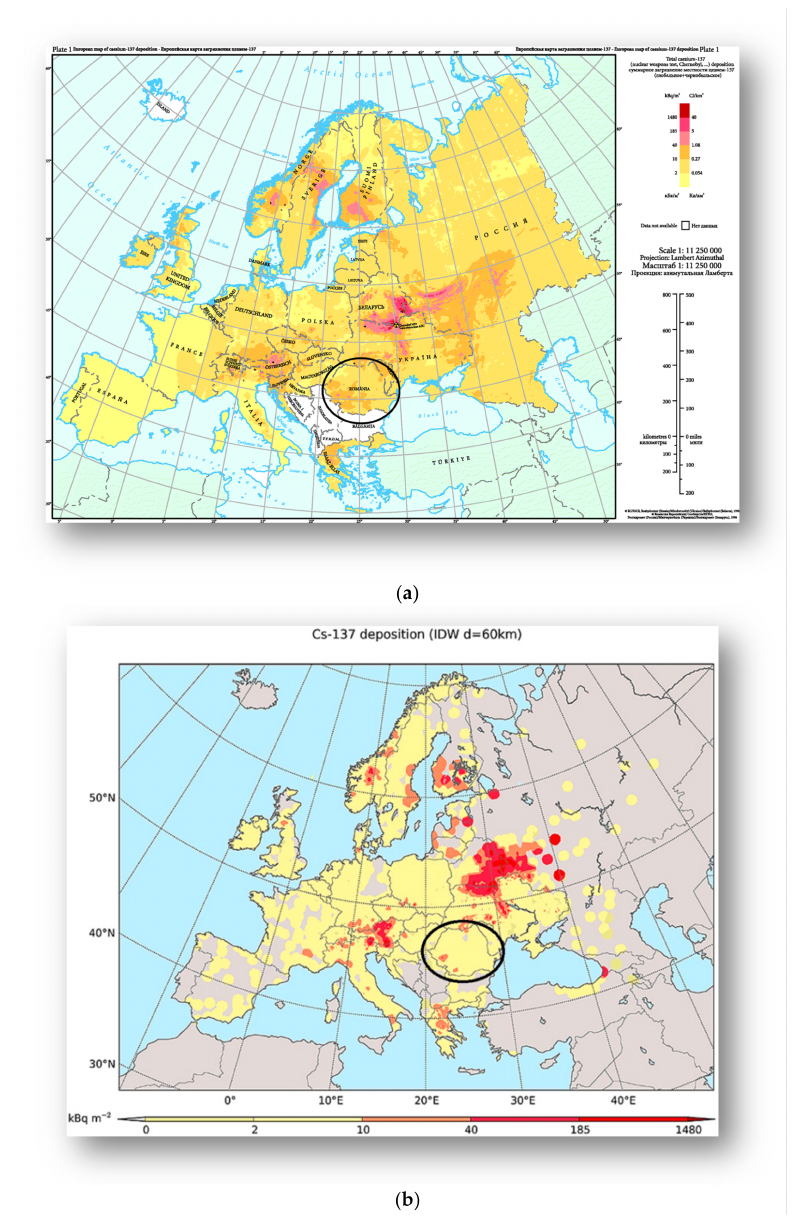
Figure 5. ( a ) Caesium 137 deposition from the Atlas of Caesium Deposition on Europe after the Chernobyl Accident EUR report nr. 16733, De Cort et al. 1998 updated in 2012 by European Environment Agency (EEA) [27]; ( b ) Updated map (2016) of Cs–137 deposition in Europe, provided from Evangeliou et al. based on 11,334 measurements in 2016, adapted with permission from [28]. Copyright 2016,